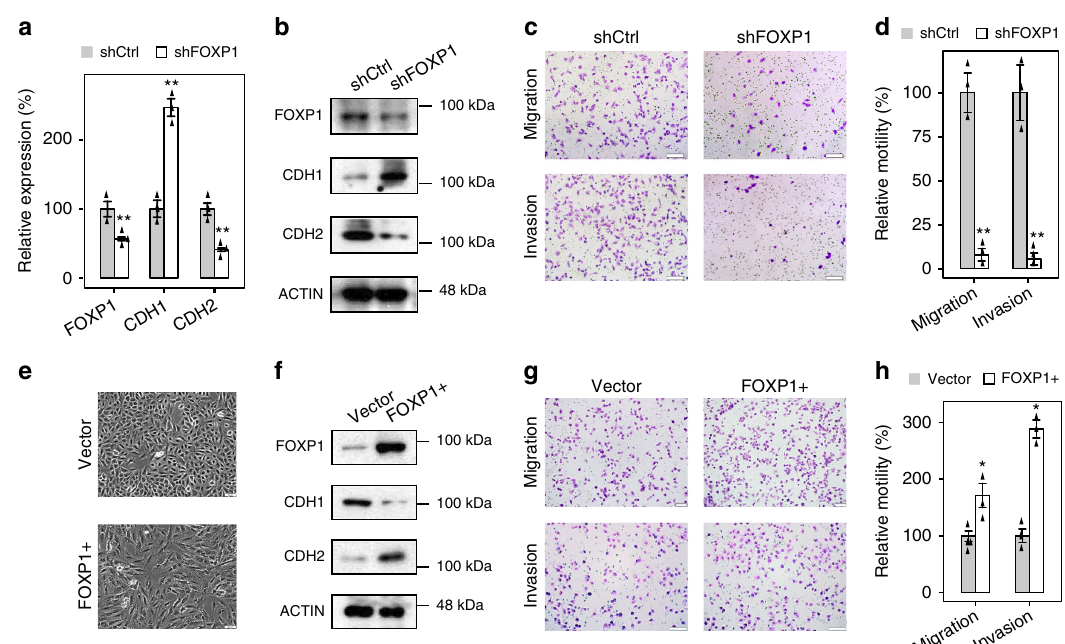
Fig. 1 FOXP1 is a critical inducer of EMT in A549 cells. a Quantitative reverse transcription polymerase chain reaction (qRT-PCR) results showing the levels of gene expression in A549 cells during TGF- β -induced EMT after silencing FOXP1 expression using speci fi c shRNA. n = 3. b Immunoblotting analysis of the protein abundance of indicated genes in A549 cells undergoing EMT after treatment with an shRNA targeting FOXP1. c A549 cells undergoing TGF- β - induced EMT were treated with an shRNA targeting FOXP1 and subjected to a migration assay (upper panel) and an invasion assay (lower panel). Scale bars: 100 μ m. d The migrated or invaded cells were quanti fi ed (bar charts). n = 6. e Morphology of A549 cells overexpressing FOXP1 or an empty control vector. f Immunoblotting analysis of the protein abundance of indicated genes in A549 cells overexpressing FOXP1 or an empty control vector. g A549 cells overexpressing FOXP1 or an empty control vector were subjected to a migration assay (upper panel) and an invasion assay (lower panel). Scale bars: 100 μ m. h The migrated or invaded cells were quanti fi ed (bar charts). n = 6; error bars indicate the means ± s.d. * p < 0.01, determined using the two-tailed Student ’ s t test. Source data are provided as a Source Data fi